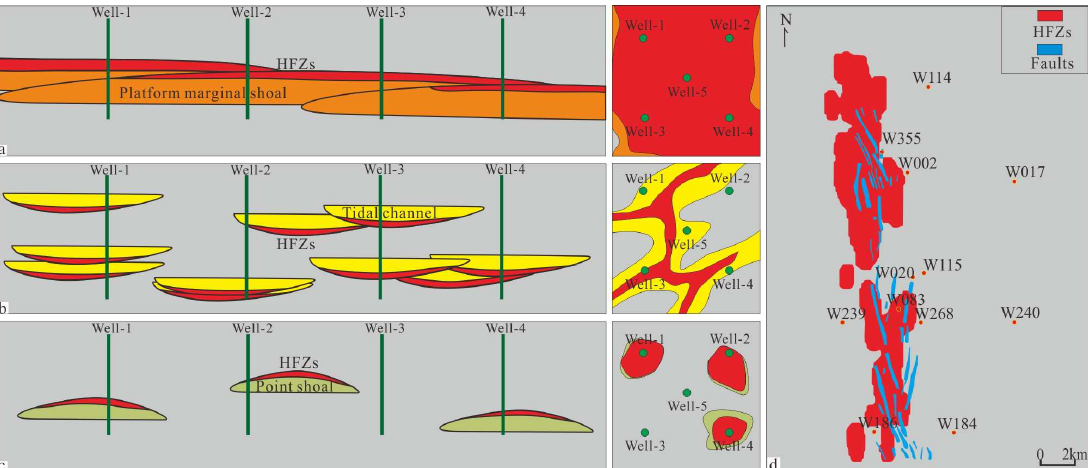
Figure 9. Distribution of different HFZs of the Mishrif Formation in X Oilfield. ( a ) Distribution of HFZs in the platform margin shoal; ( b ) distribution of HFZs in the tidal channel; ( c ) distribution of HFZs in the point shoal; ( d ) The distribution of the HFZs in the point shoal is controlled by faults.